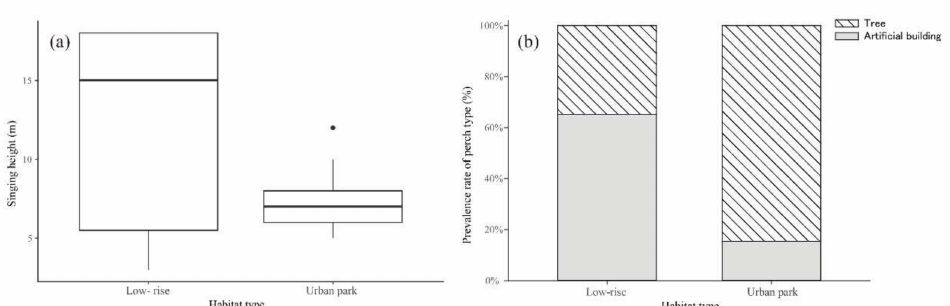
Figure 4. Differences in singing height ( a ) and perch type ( b ) of the oriental magpie-robins between low-rise residential areas and urban parks.